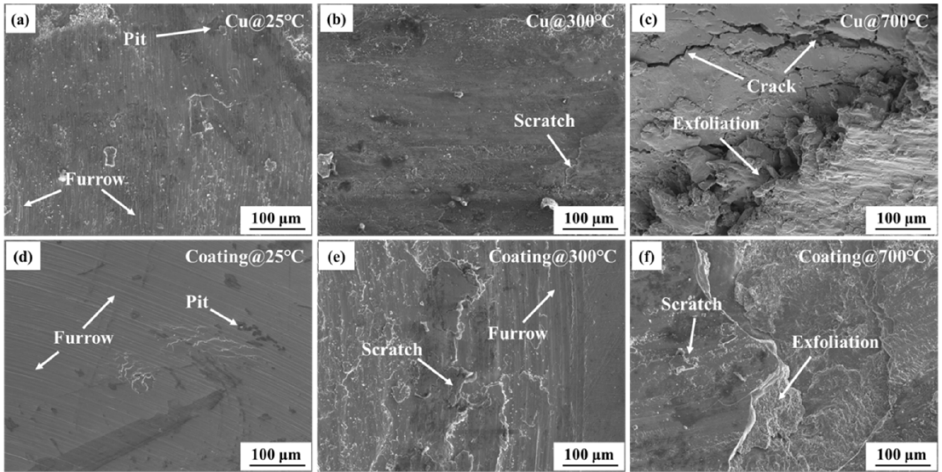
Figure 12. Worn surface of the pure Cu and Cu35Ni25Co25Cr15 HEA coating deposited under a welding current of 150 A at different temperatures: ( a,d ) 25 °C, ( b,e ) 300 °C, and ( c,f ) 700 °C,